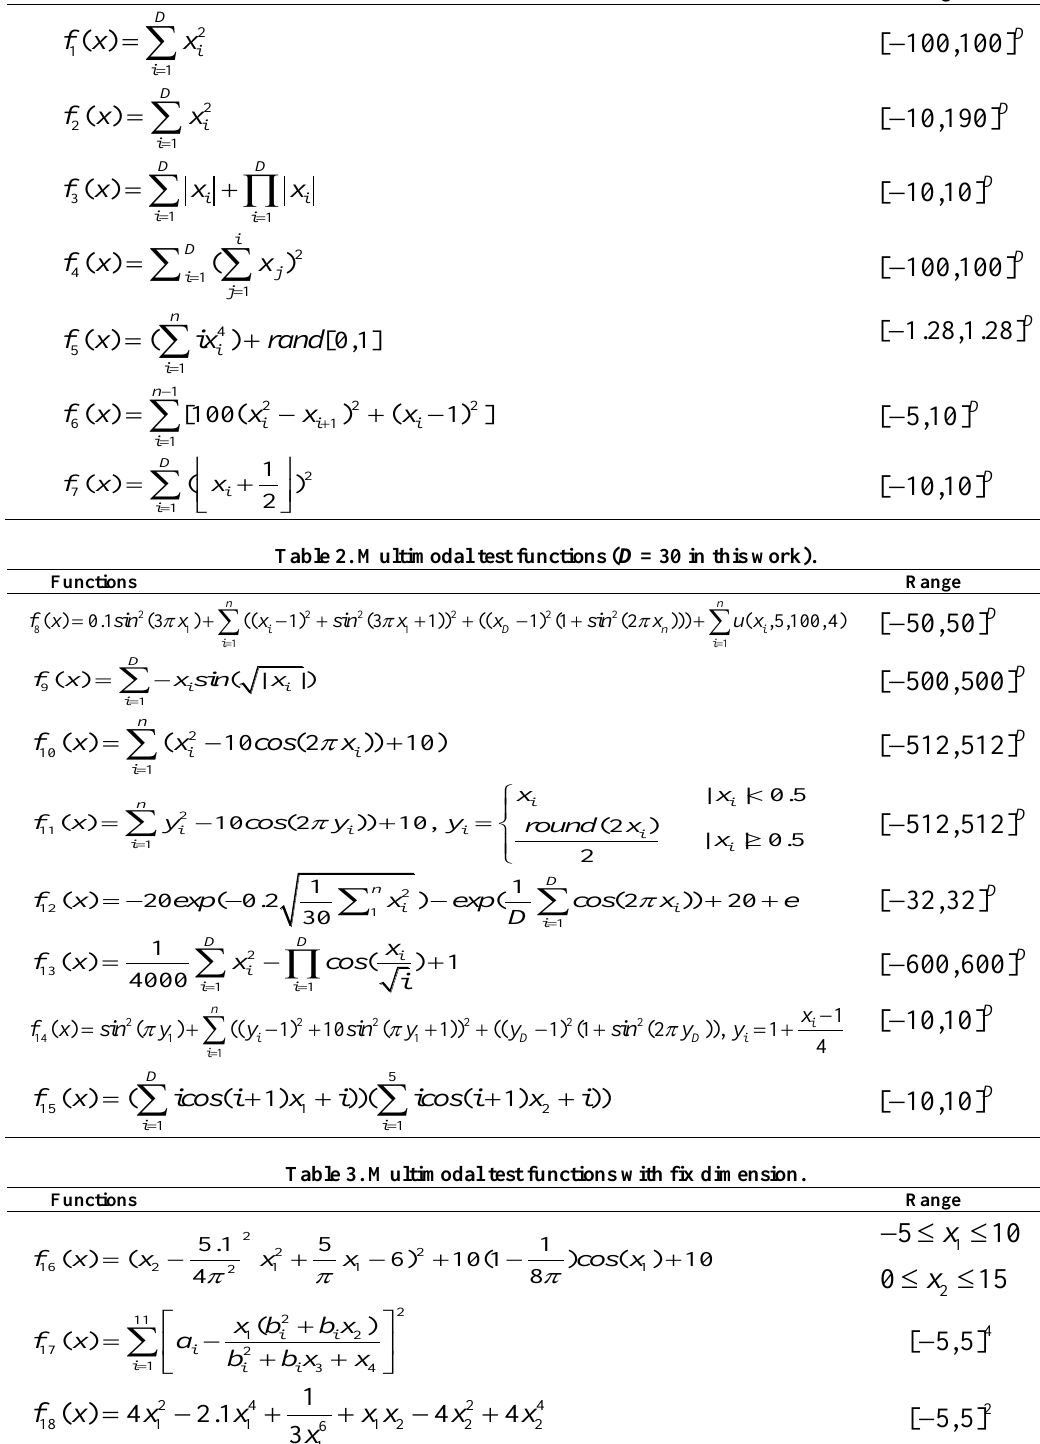
Table 1. Unimodal test functions ( D = 30 in this work). Functions